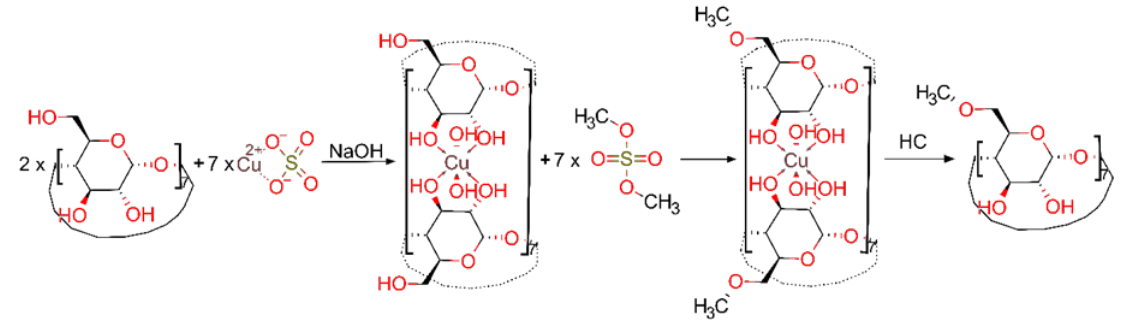
Figure 2. Proposed protection mechanism.